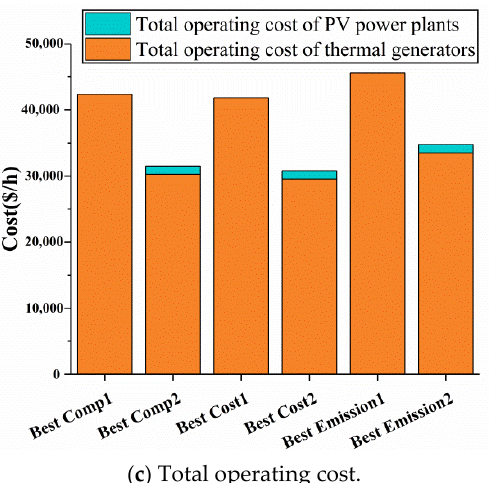
Figure 11. The active output power and total operating cost in the three scenarios (1-case 1, 2-case 2).